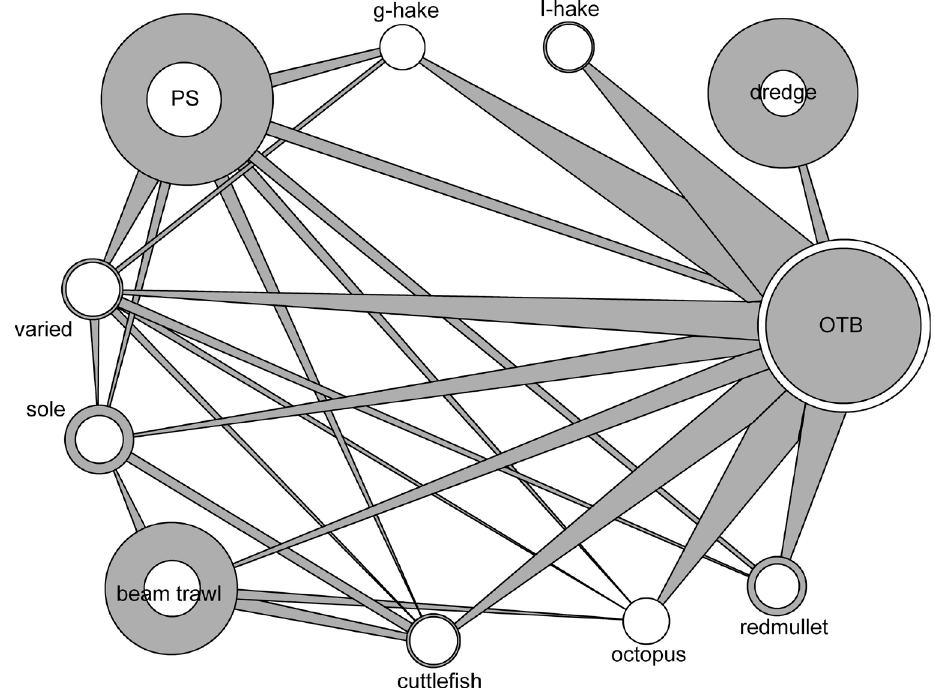
F ig . 4. – Sociogram of 11 fleets in Vilanova i la Geltrú. The white circle is proportional to T (dominance) the grey one to the main diagonal (independence). The arrows corresponding to values smaller than 5% of the interval of [S] have been eliminated for clarity. Of the 55 total pair relationships only 25 have been